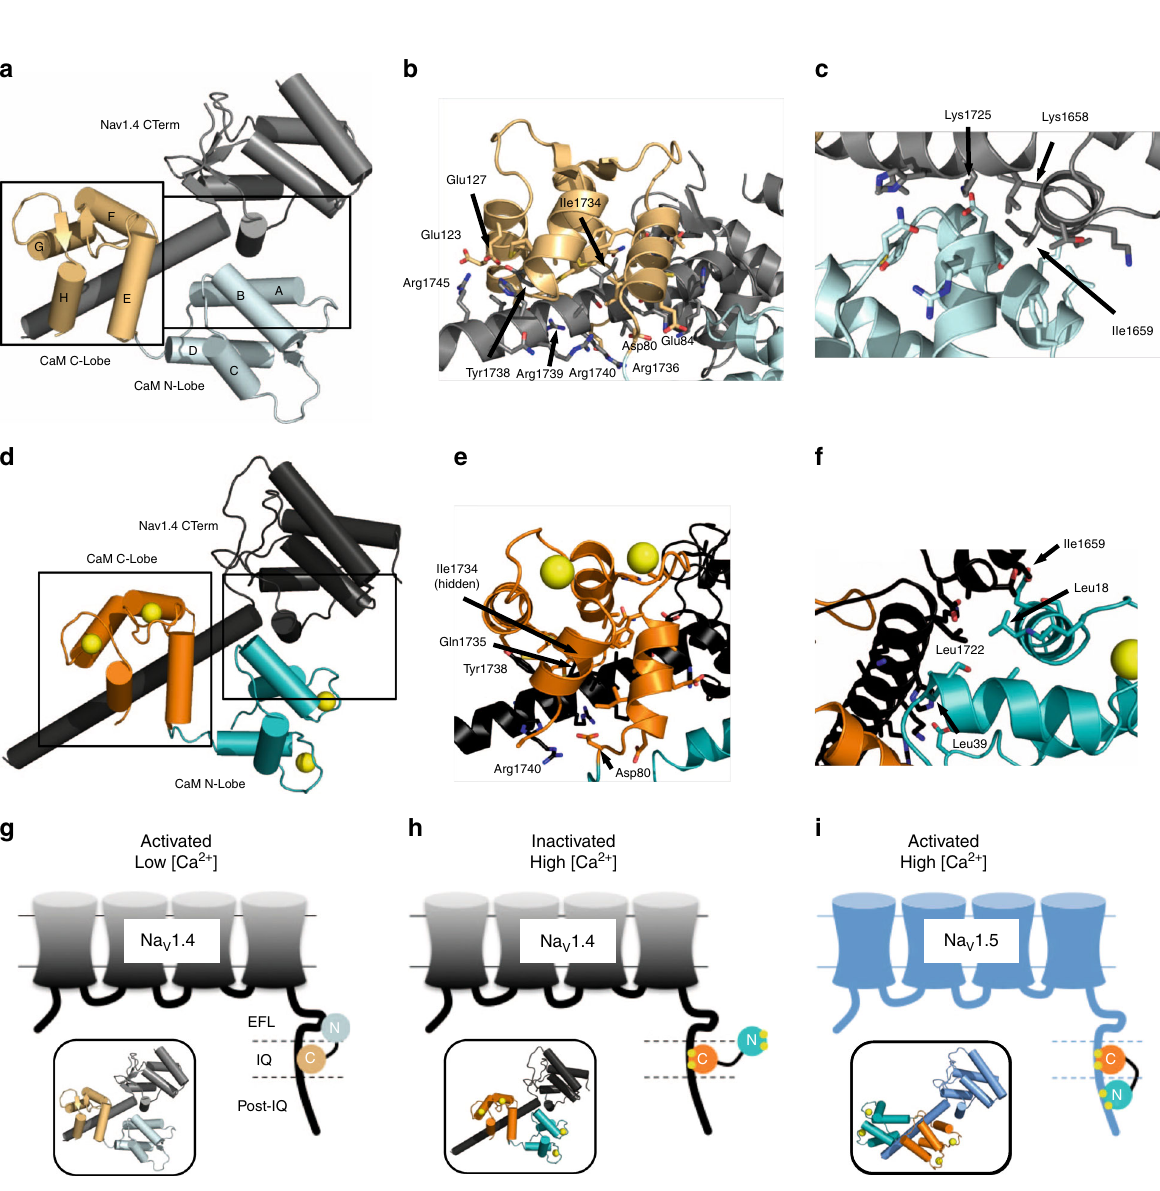
Fig. 2 Structures of Na V 1.4 CTerm in complex with CaM, ± Ca 2 + . a 1.8 Å resolution structure of the complex of the Na V 1.4 CTerm and apo CaM. CTerm colored gray and CaM light teal (N-lobe) and light orange (C-lobe). b Close-up of the apo C-lobe and helix α VI interactions. c Close-up of N-lobe and EFL interaction. d 3.3 Å resolution structure of the complex of the Na V 1.4 CTerm and (Ca 2 + ) 4 -CaM. CTerm is colored black and CaM dark teal (N-lobe) and dark orange (C-lobe). e Close-up of Ca 2 + -C-lobe and helix α VI interactions. f Close-up of Ca 2 + -N-lobe and EFL interaction. Residues shown have more than 10 Å 2 BSA. g – i Schematics of CaM N-lobe control in Na V regulation. g Activated conformation of CaM and Na V 1.4 (PDB ID: 6MBA). h Ca 2 + -inactivated conformation of CaM and Na V 1.4 (PDB ID: 6MC9). i Ca 2 + -insensitive conformation of CaM and Na V 1.5 (PDB ID: 4JQ0, FHF molecule not